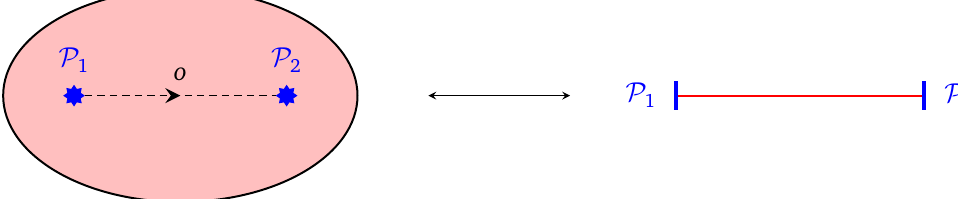
Figure 6: Inserting a Wilson line in rep R ∨ (denoted by red) in the 5 d theory is equivalent to compactifying the R along the whole sphere (denoted by red background) in the 6 d